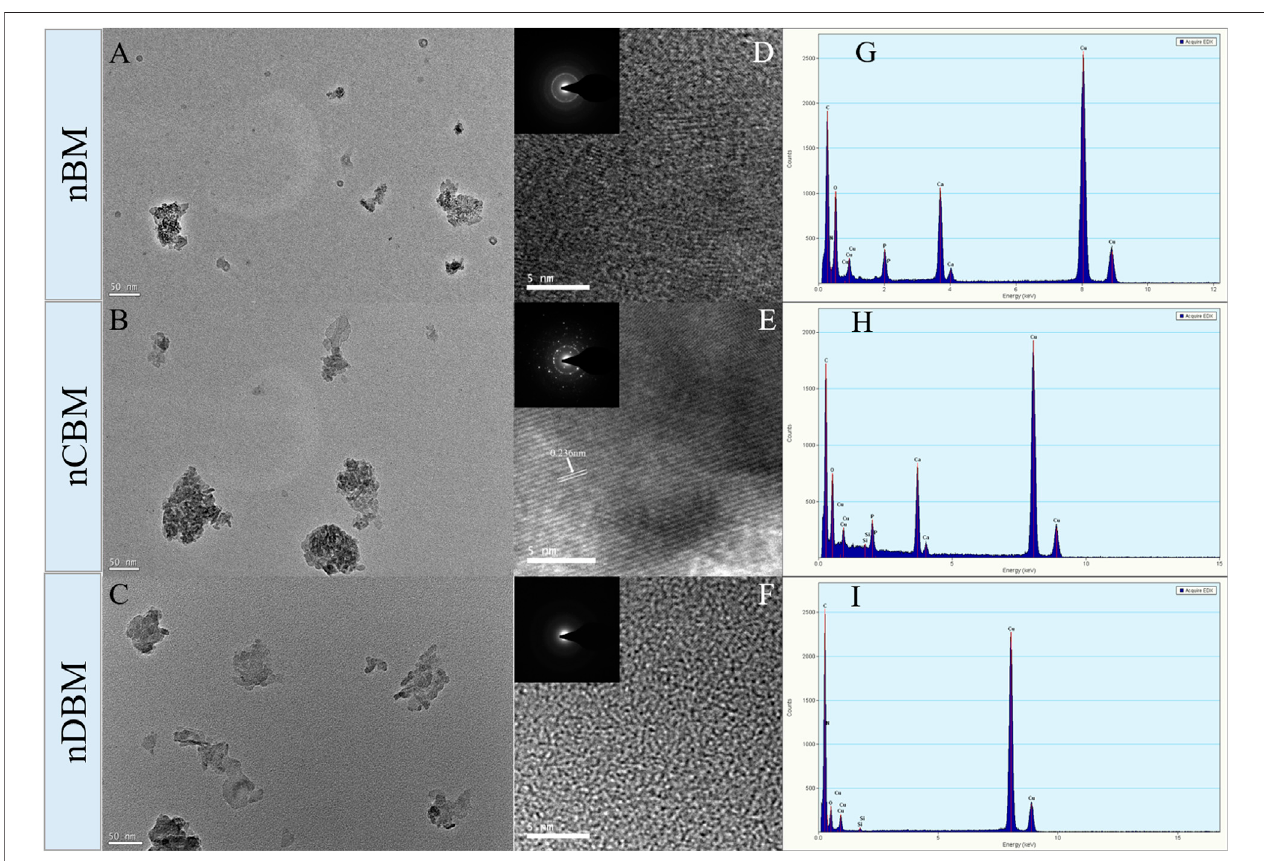
FIGURE 2 | Transmission electron microscopy (TEM) image (A,B,C) , high-resolution TEM image (D,E,F) , and energy-dispersive X-ray spectroscopy spectrum (G,H,I) of different nano bone powders. Insets are the corresponding selected area electron diffraction patterns.